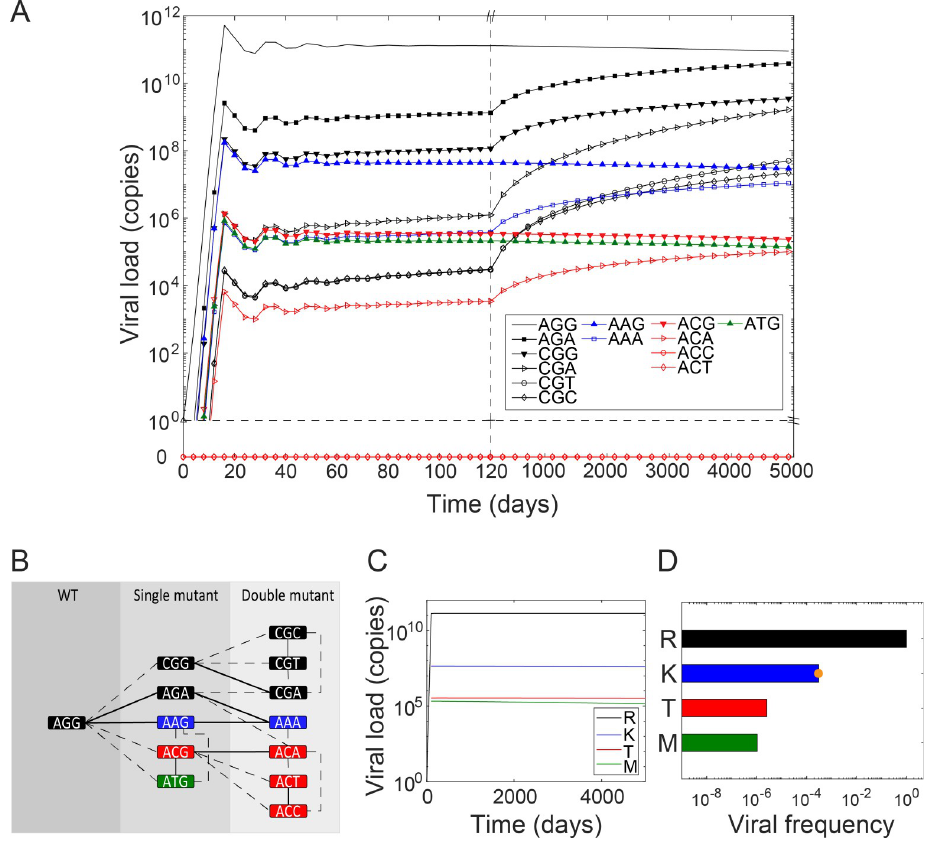
Fig 4. Extracellular dynamics, the mutational pathway map, and the mutant spectrum. (A) The time evolution of virions containing the infecting strain (AGG) and each of the possible mutant codons, color coded by the amino acids they encode. (B) A map of mutational pathways leading from one codon to another. Transitions are in solid lines and transversions in dashed lines. The lines connect codons separated by a single mutation. The shades of grey indicate the number of mutations from the infecting strain, AGG. (C) The time evolution of the populations of virions grouped by the amino acid variants they contain. (D) Frequencies of the different mutants at steady state. Shown for comparison is the database value of the mutant R155K for HCV genotype 1a (orange dot) [33].